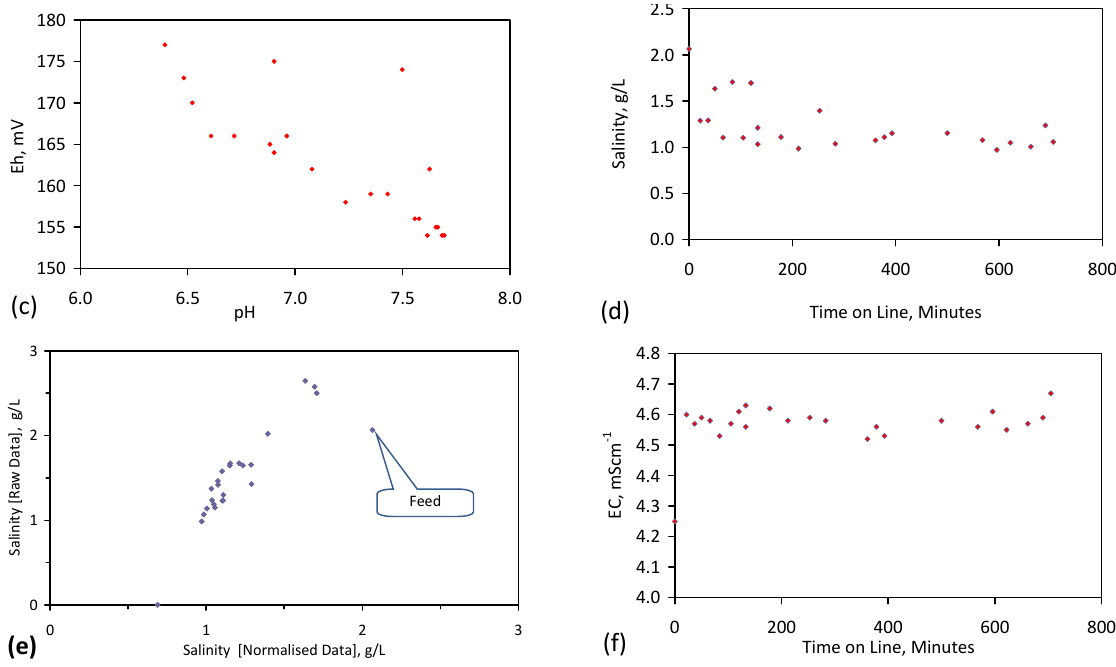
Figure C30. ZVM TPA example Trial E146. 10th Reuse; Operating Temperature: 16–21 °C; Oxidising Environment: Water volume in the reactor = 0.24 m 3 ; ZVM TPA from Trial E145 in a cartridge = 0.4 kg; Air flow = 120 L·h − 1 . ( a ) Eh vs. time; ( b ) pH vs. time; ( c ) pH vs. Eh; ( d ) Salinity vs. time; ( e ) Salinity calculated from normalised data vs. salinity calculated from raw data; ( f ) EC vs. time.